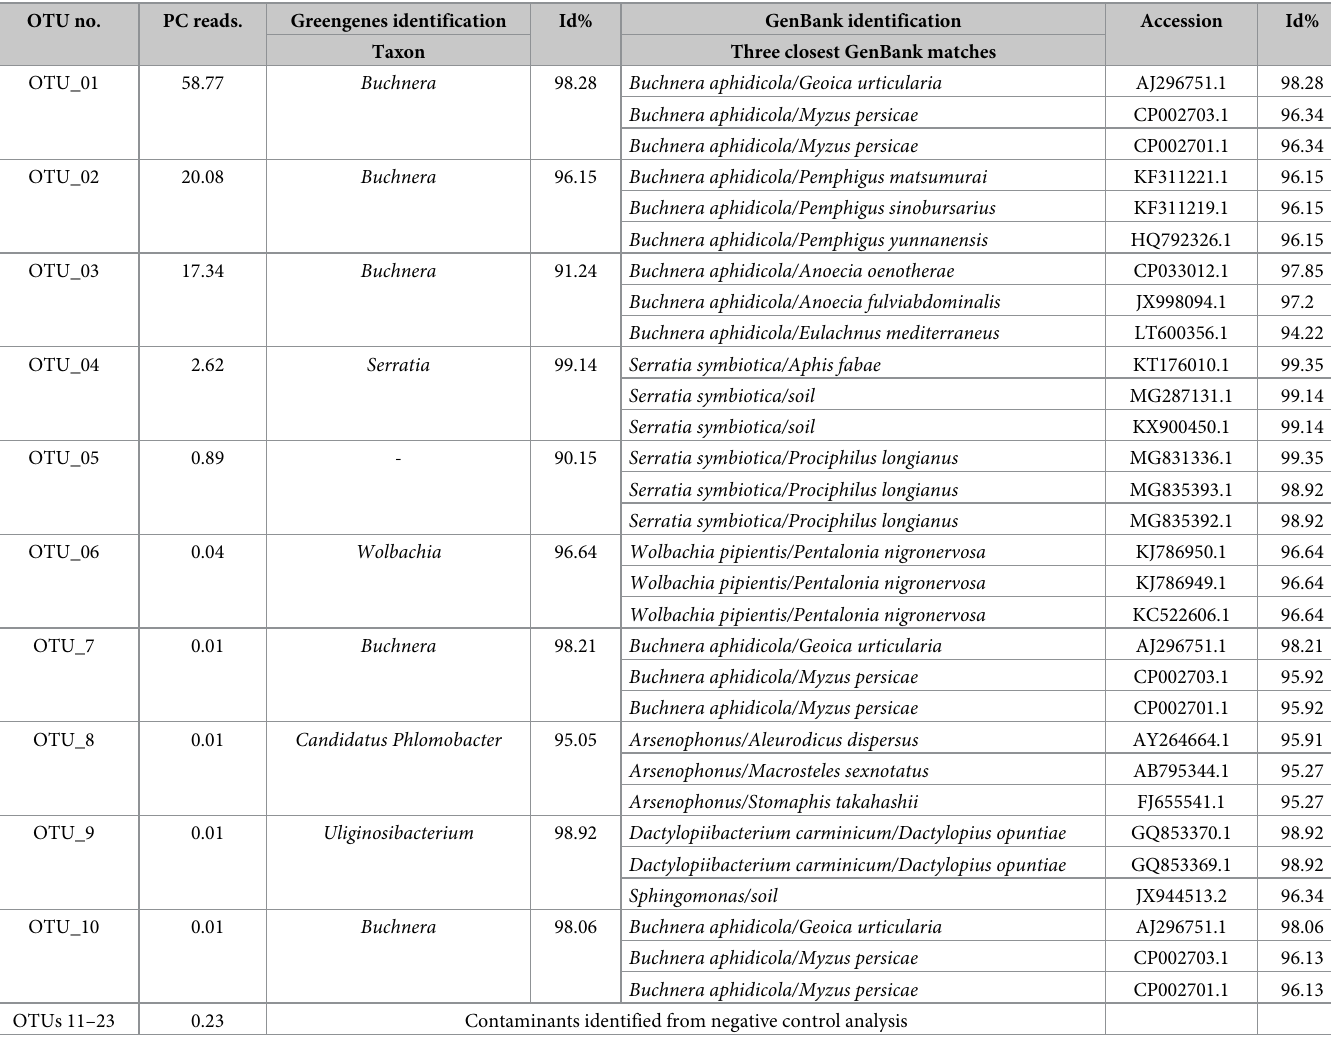
Table 2. Taxonomic assignment of OTUs by Greengenes and GenBank, including the three top BLAST hits, GenBank accession numbers and % identity. OTU no. PC